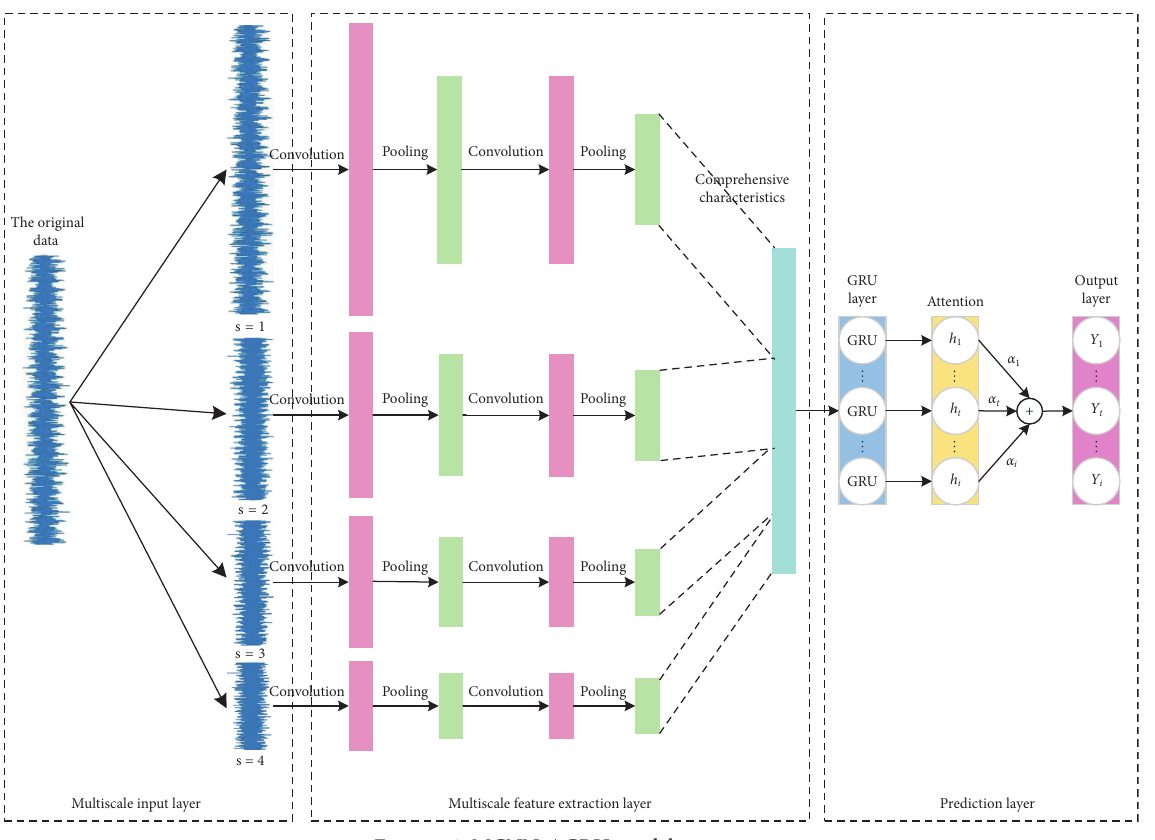
Figure 6: MCNN-AGRU model structure.